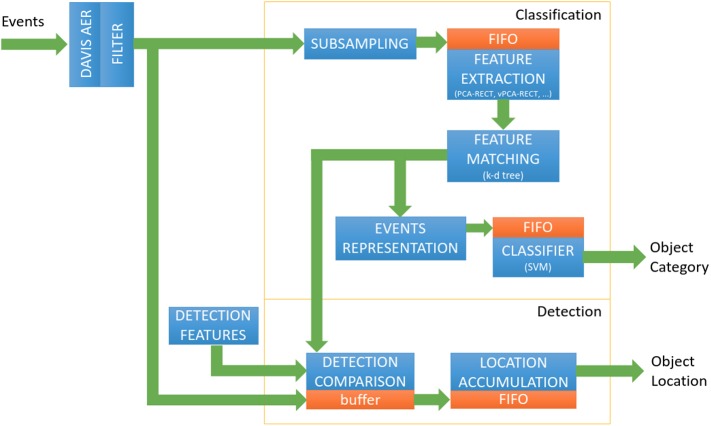
Pipeline of the proposed system.